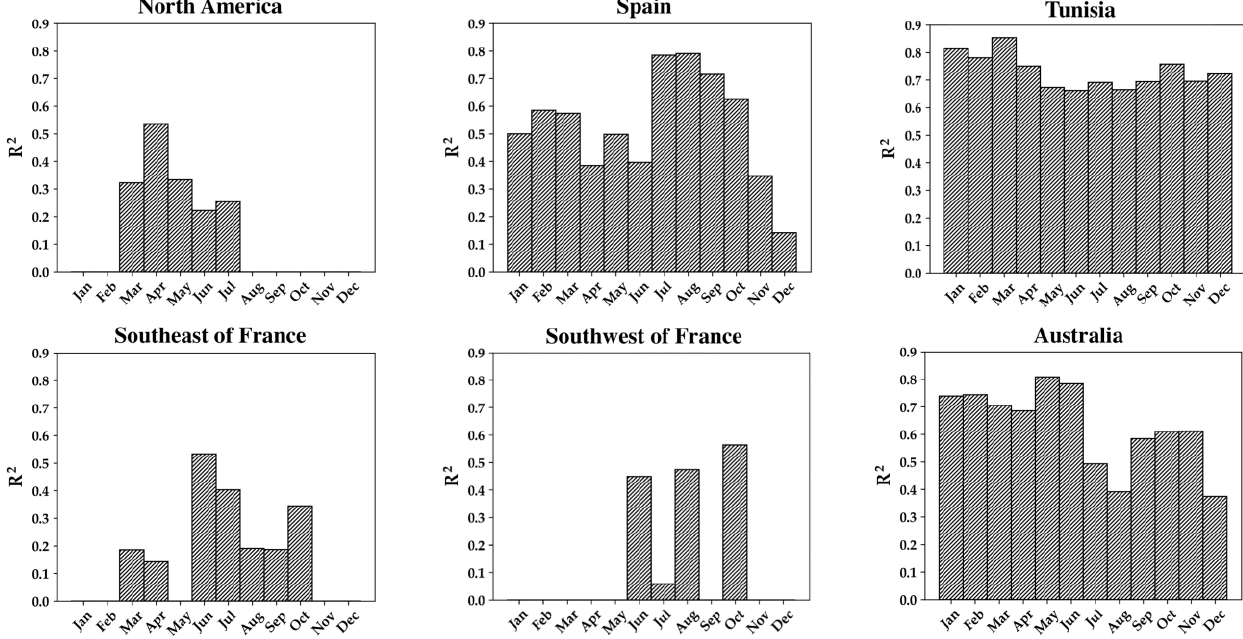
Figure 3. Correlation between S2 and S3 NDVI at 1km grid scale each month from January to December 2019 for the six study regions. For months with no bars, it means that there is no correlation between S2 and S3